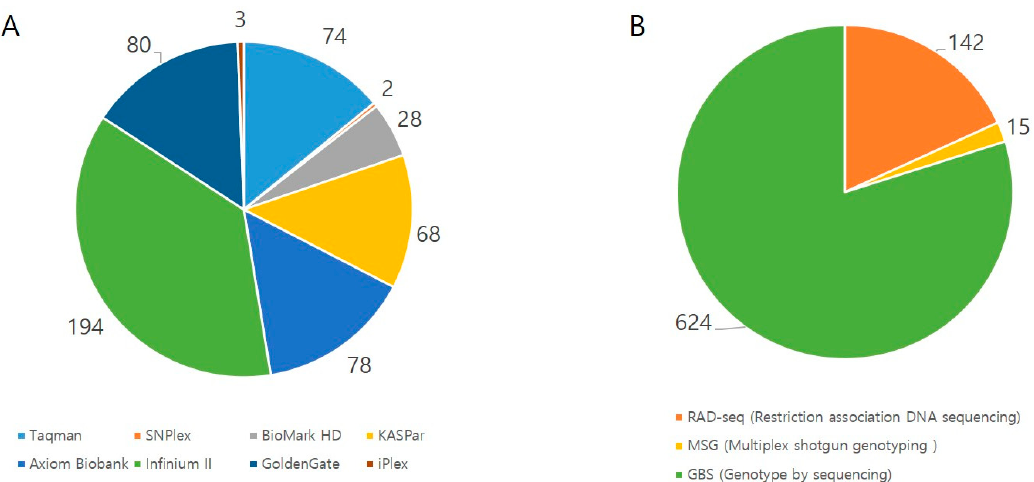
Figure 3. Publication search results (the NCBI’s PubMed database, www.pubmed.gov) from 2011 to